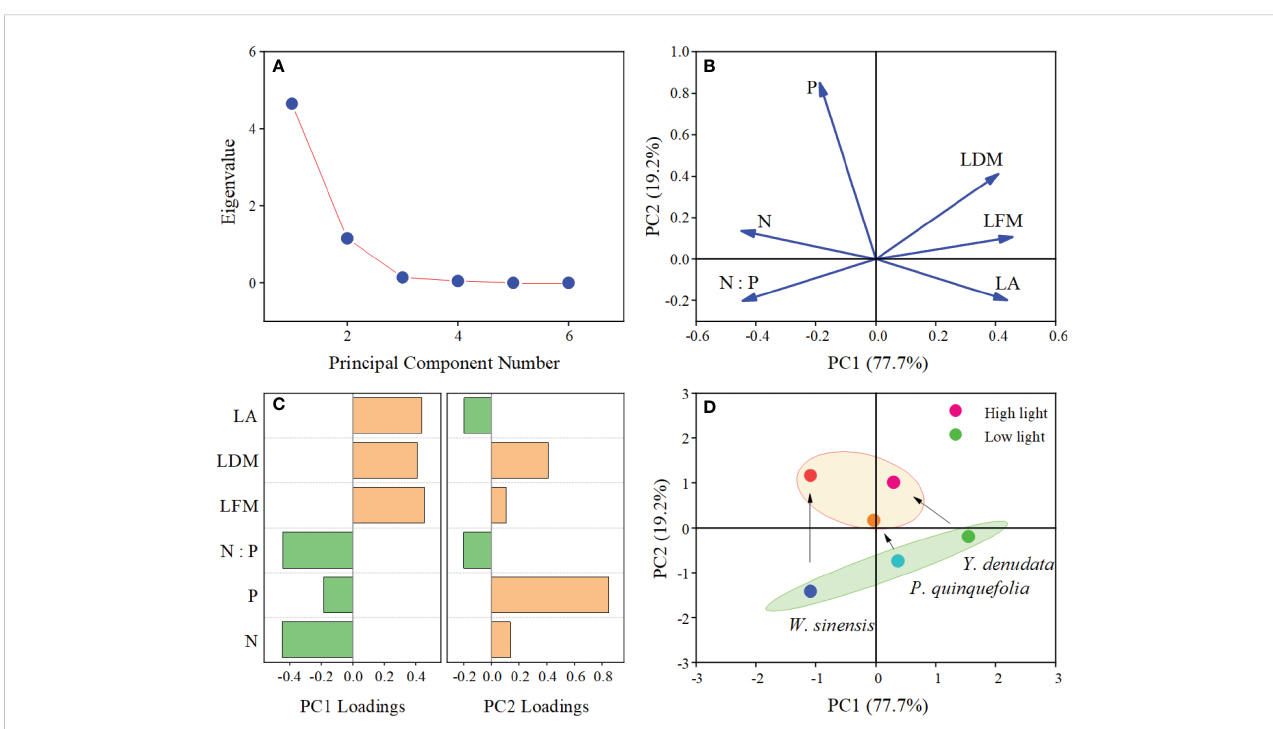
FIGURE 4 PCA analysis of leaf traits of urban plants in different light habitats. (A) Scree plot; (B) Loading plot; (C) Loadings of plant traits on the fi rst and second axes; (D) Score plot and strategy shifts of the different plants under different light habitats.